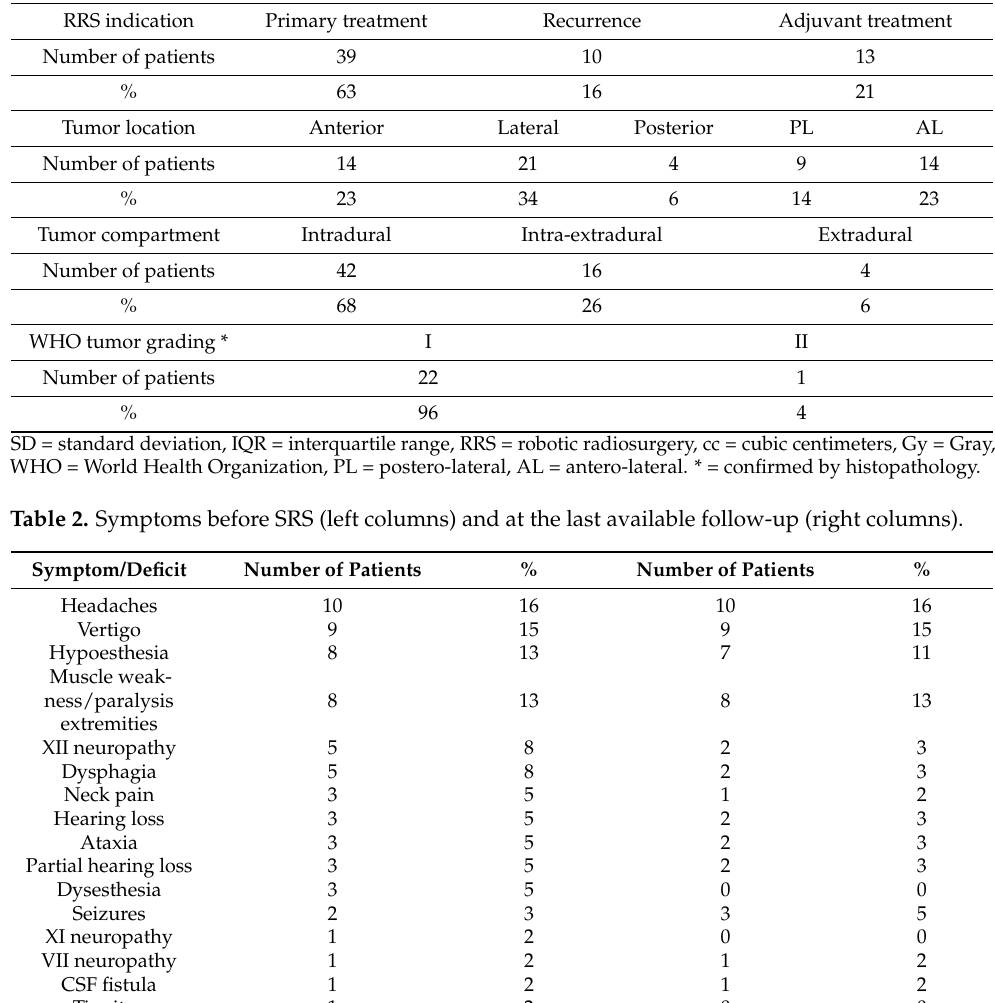
The median prescription dose and isodose line were 14 Gy and 70%, respectively. Fifty out of 62 tumors (81%) were treated with one fraction. The remaining received three to five fractions, with doses ranging from 19.5 to 25 Gy. The median tumor volumes of primarily and secondarily treated tumors were 2.2 cubic centimeters (cc) and 3.9 cc, respectively. Tumor volumes for single-session treatments were significantly smaller compared to multi- session SRS (median sizes: 2.1 versus 5.3 cc, p < 0.01). The median maximum dose to the brain stem was 13.5 Gy. The treatment characteristics are summarized in Table